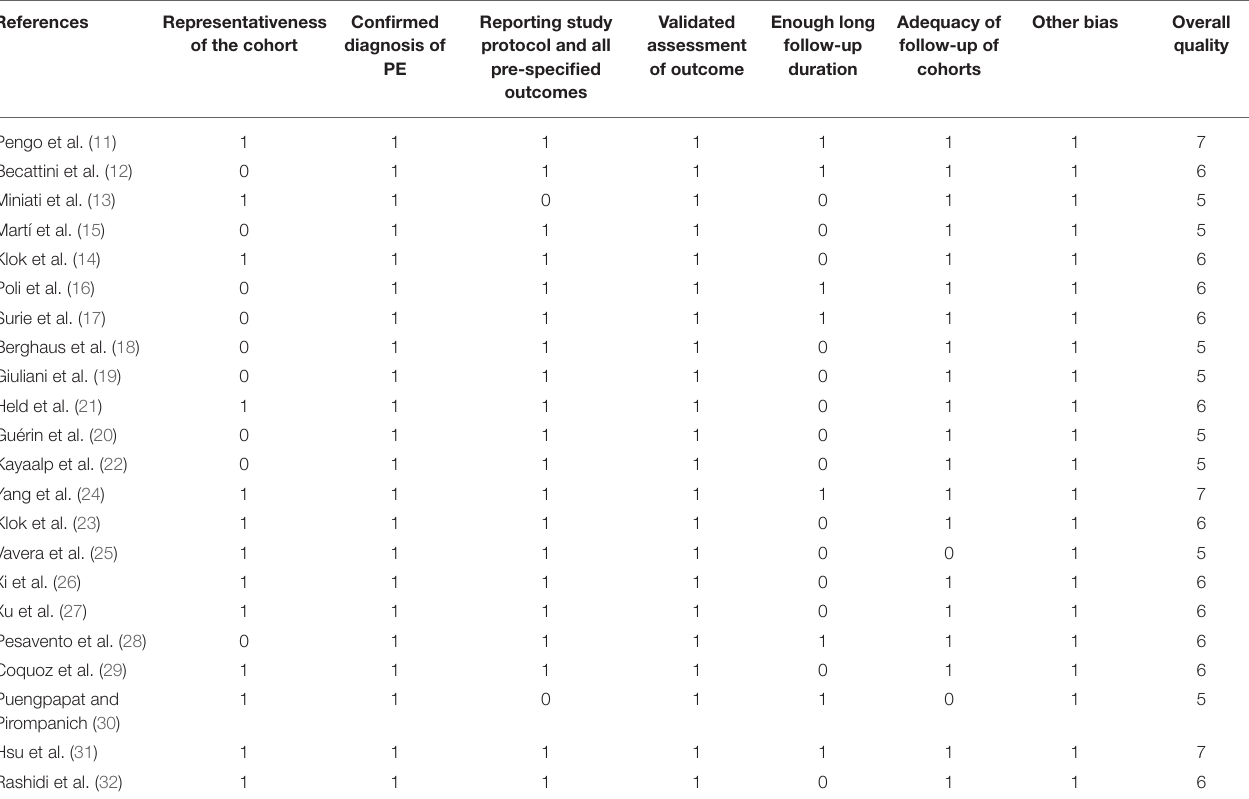
TABLE 2 | Details of study quality evaluation according to the Cochrane’s Handbook